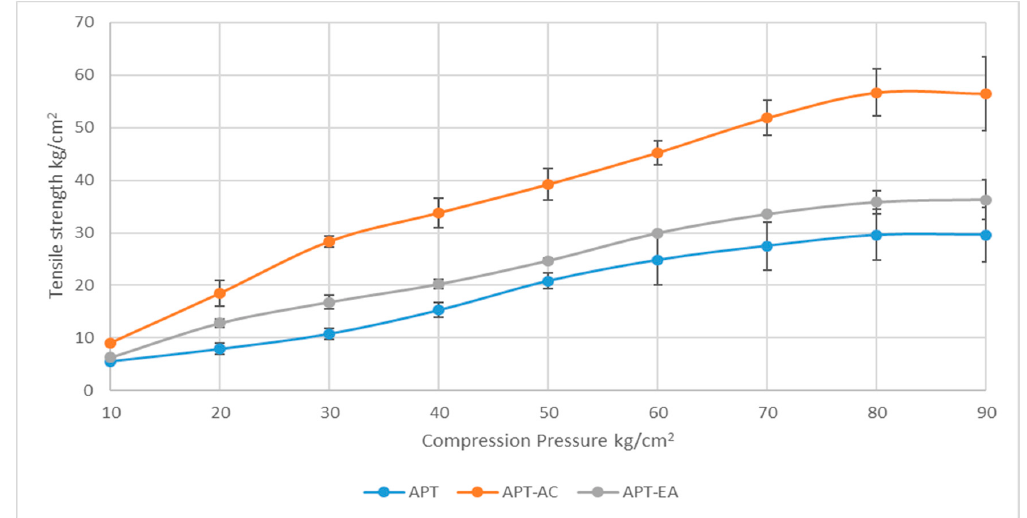
Figure 9. Plots of tensile strength against compression pressure. All values were calculated as mean ± SD, n = 3. ANOVA at the p < 0.05 level showed a significant difference.